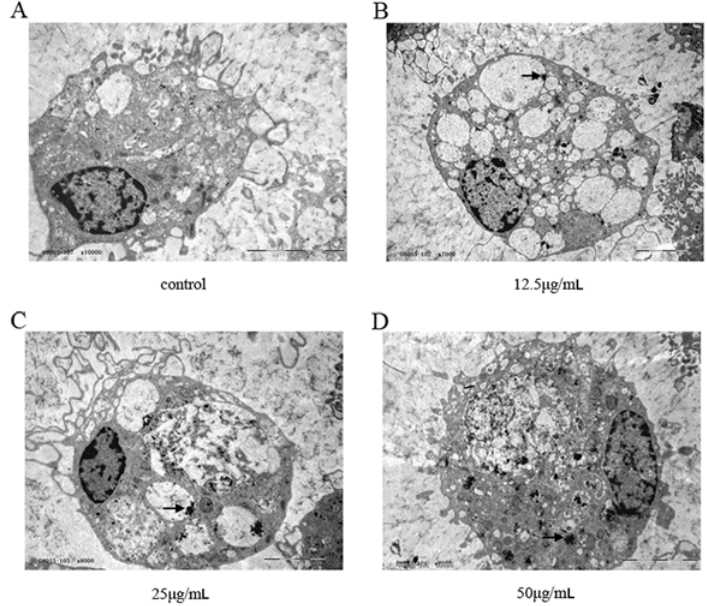
Figure 5. Microcosmic conditions of superparamagnetic iron oxide (SPIO) uptake by endothelial progenitor cells (after SPIO transfection at different concentrations. A , Control group; SPIO concentrations: B , 12.5 m g/mL; C , 25 m g/mL; and D , 50 m g/mL (arrow indicates SPIO granules in cells) (scale bar 5 m m).